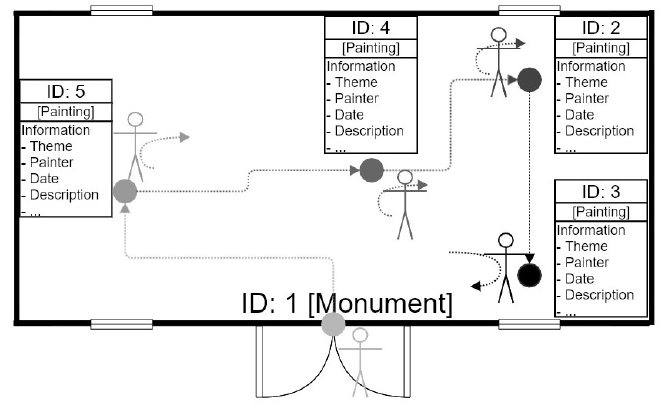
Figure 11. Complete mapping